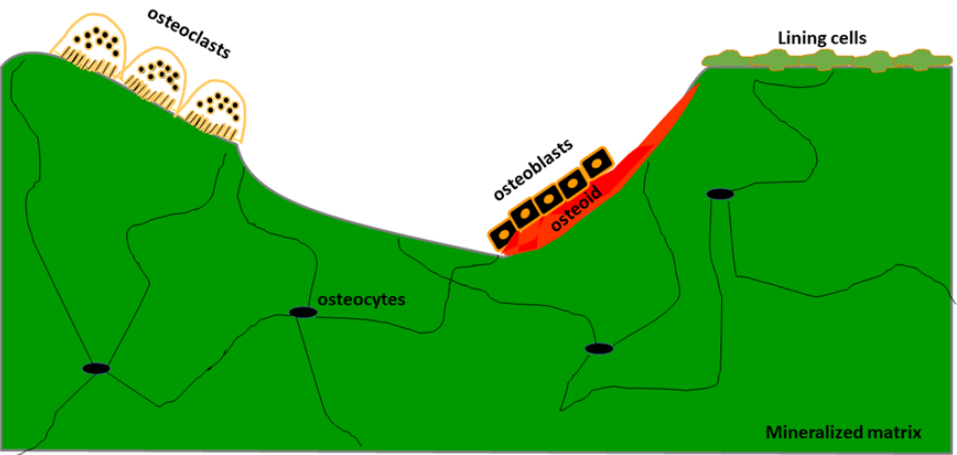
Figure 3. Schematic representation of Bone Multicellular Unit (BMU).